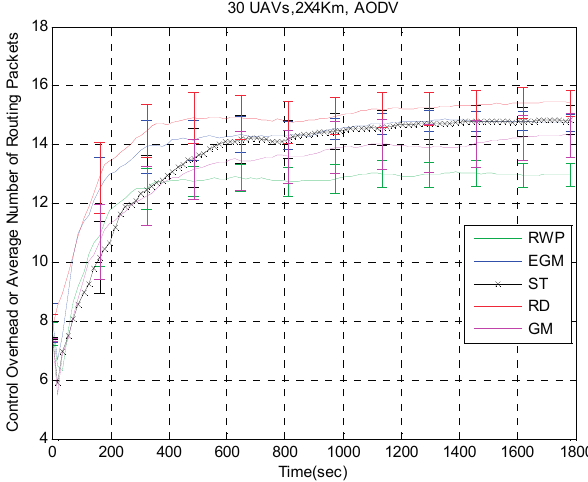
Figure 10. Routing overhead of ad hoc on-demand distance vector (AODV) under various mobility